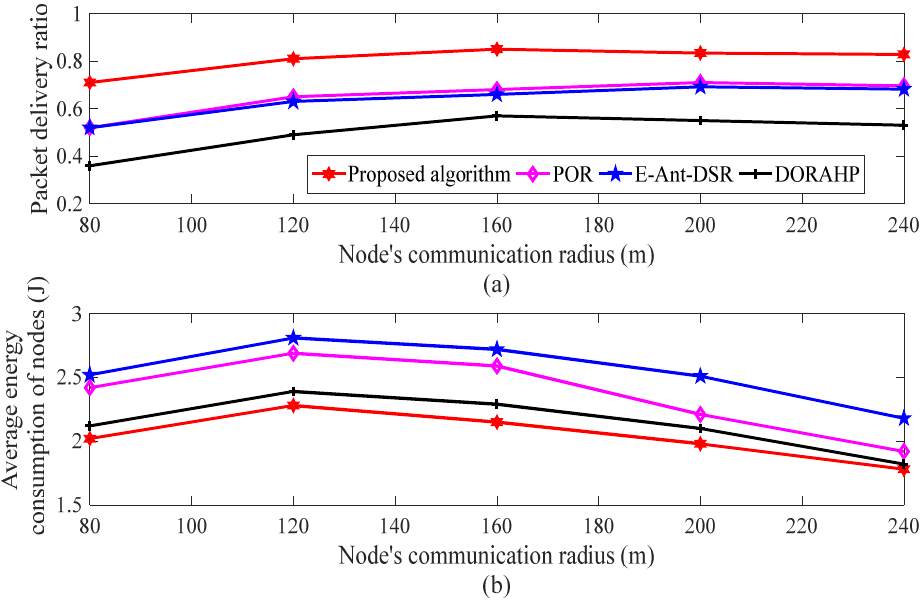
Figure 7. Comparison with variable node’s communication radius. ( a ) Packet delivery ratio. ( b ) Average energy consumption of nodes.